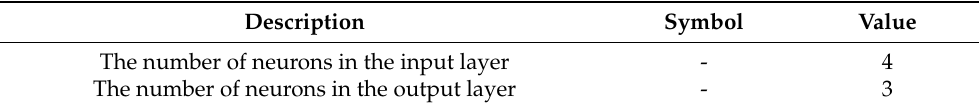
Table 5. PSO-DBN model